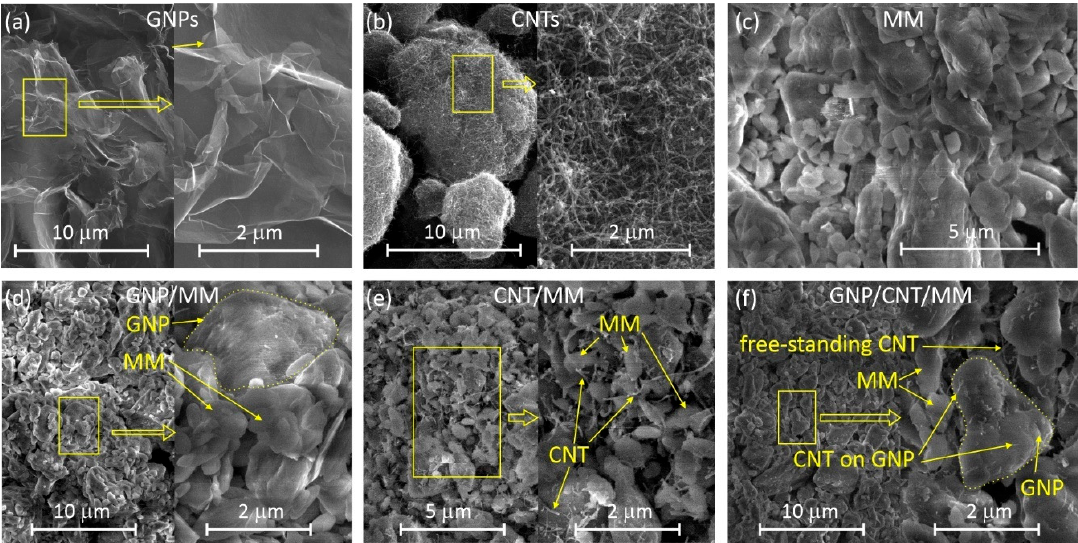
Figure 1. SEM images of the starting materials and as-prepared powders: ( a ) GNPs, ( b ) CNTs, ( c ) MM, ( d ) GNP/MM, ( e ) CNT/MM, ( f ) GNP/CNT/MM.